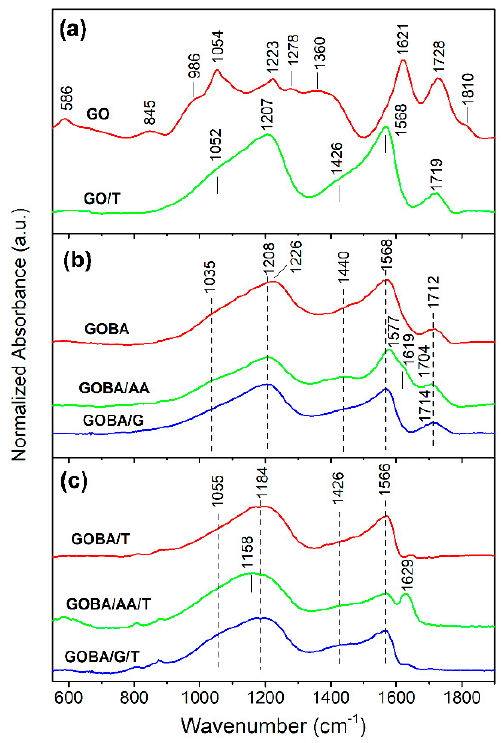
Figure 2. ( a ) Fourier transform infrared (FTIR) spectra of pristine GO and GO/T; ( b ) FTIR spectra of mrGO samples; ( c ) FTIR spectra of trGO samples.